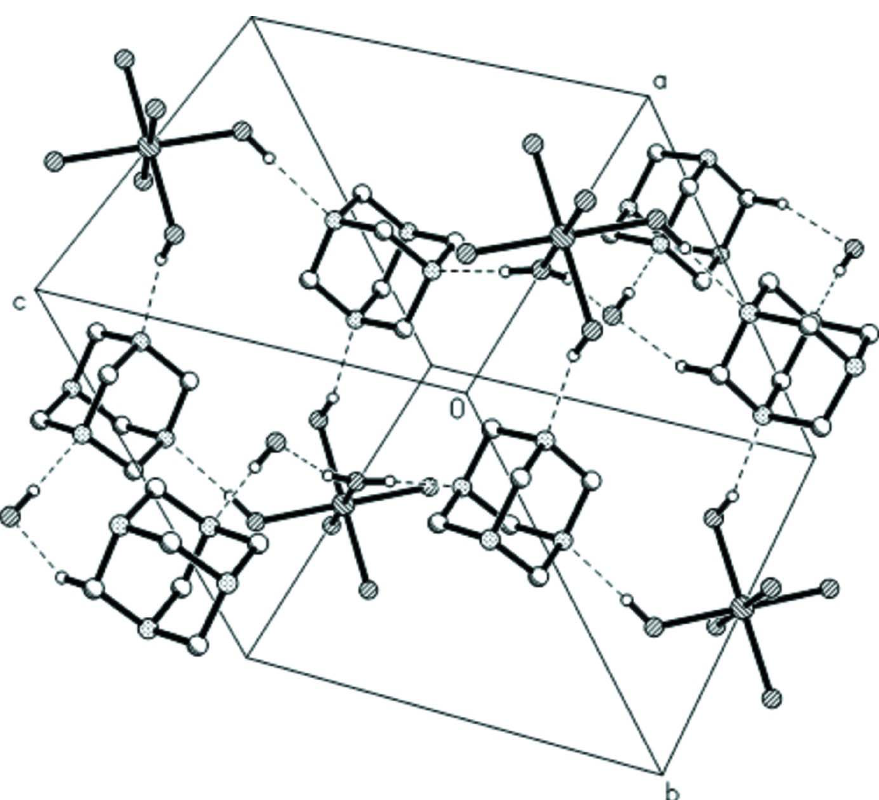
Figure 2 Hydrogen bonding [dashed lines] in part of the crystal structure between [Cu(H molecules and water